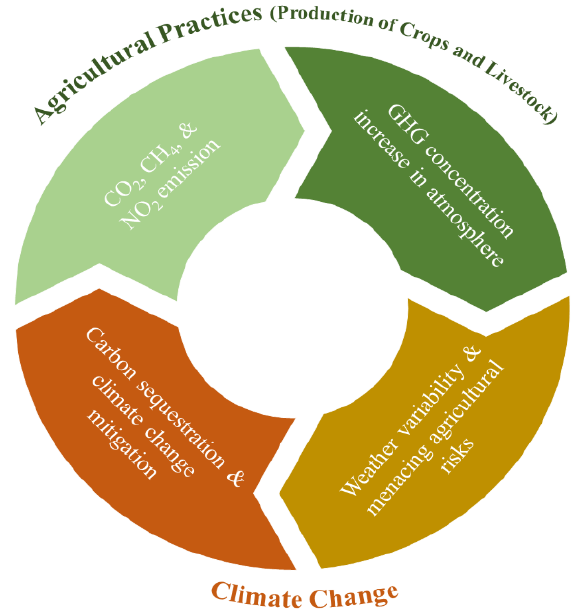
Figure 2. The effect of climate change and agriculture on each other [22].